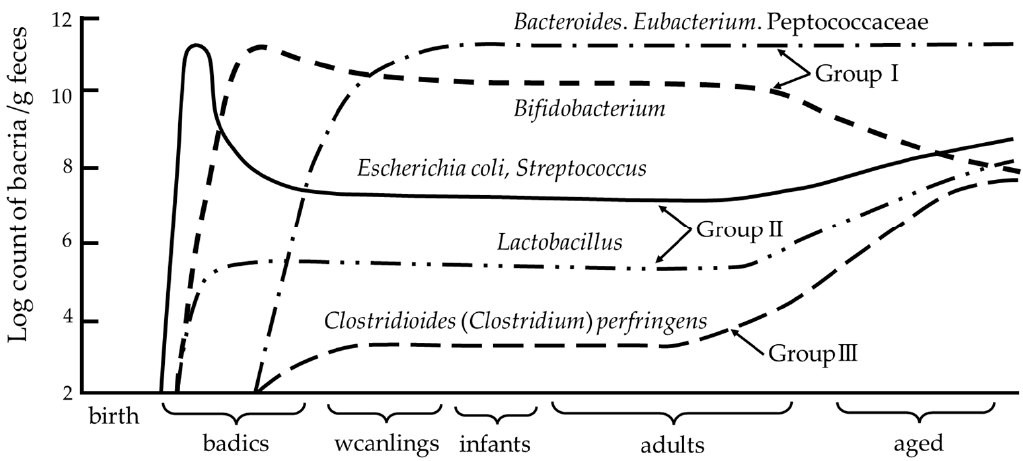
Figure 1. Age-related changes in intestinal microbiota.